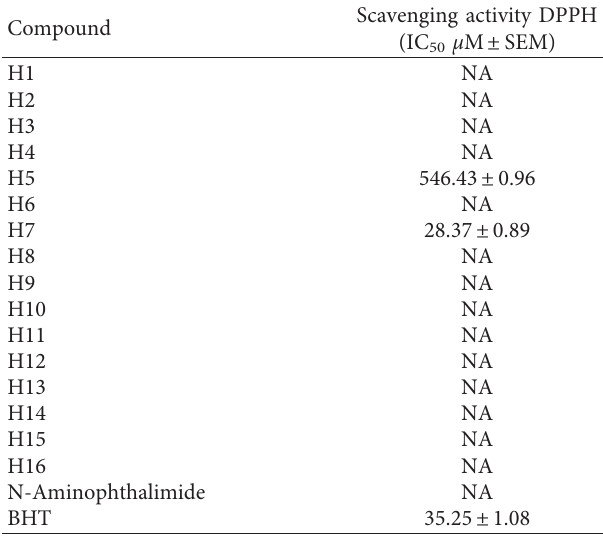
Table 2: IC 50 values of DPPH free radical scavenging activity of imines. Compound